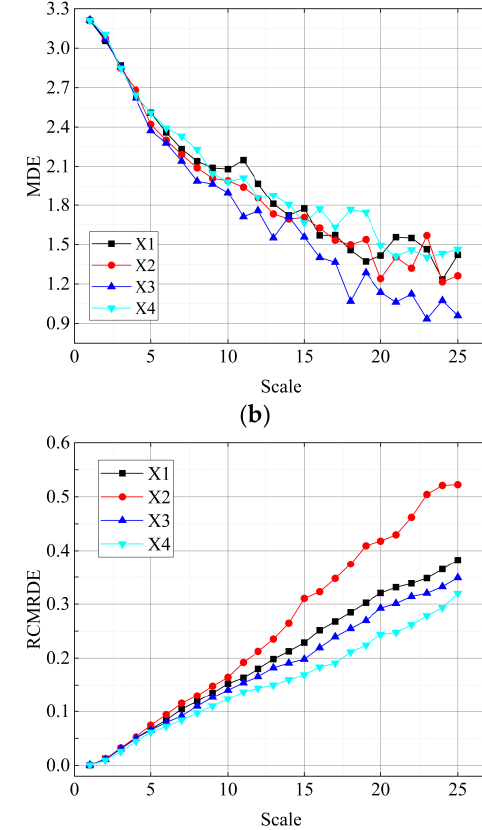
signals with different damage degrees; ( b ) MDE value curves; ( c ) RCMDE value curves; ( d ) RCMRDE